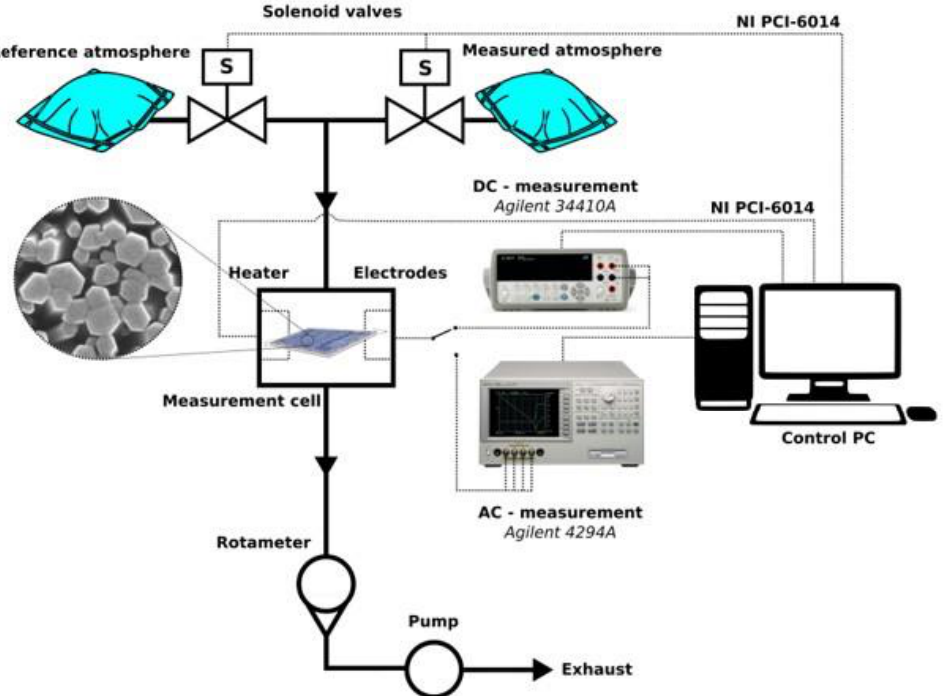
Figure 2. Block diagram of the station for measuring the chemiresistor response.